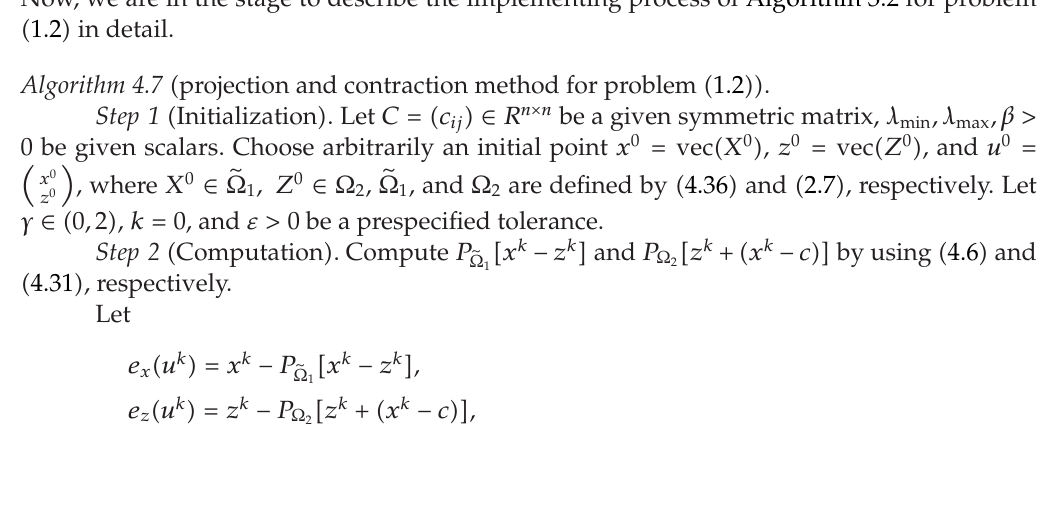
Algorithm 4.7 (cid:2) projection and contraction method for problem (cid:2) 1.2 (cid:3)(cid:3)